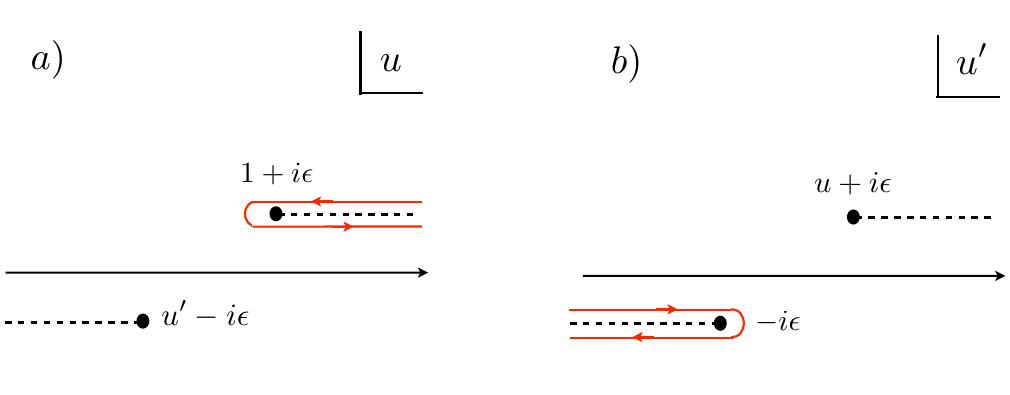
0 (cid:0) i(cid:15) and